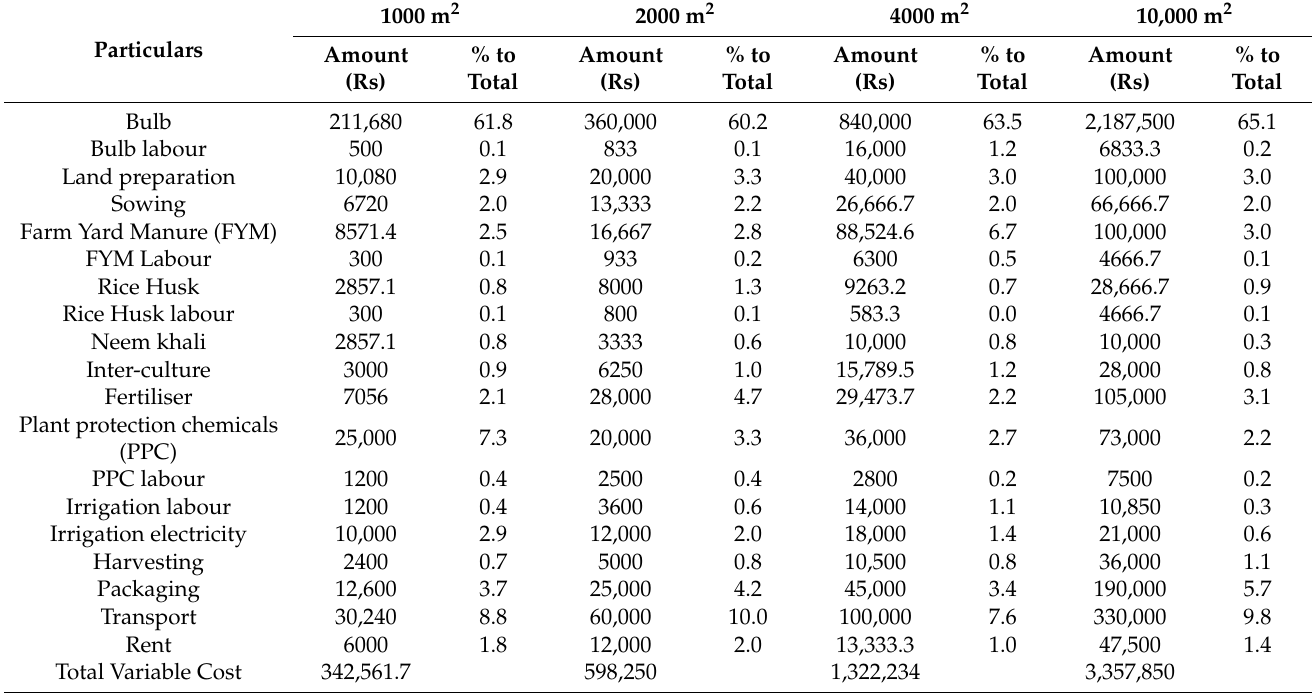
Table 12. Cost of cultivation of gerbera for different size category of the polyhouses in Dehradun district of Uttarakhand (Rs).